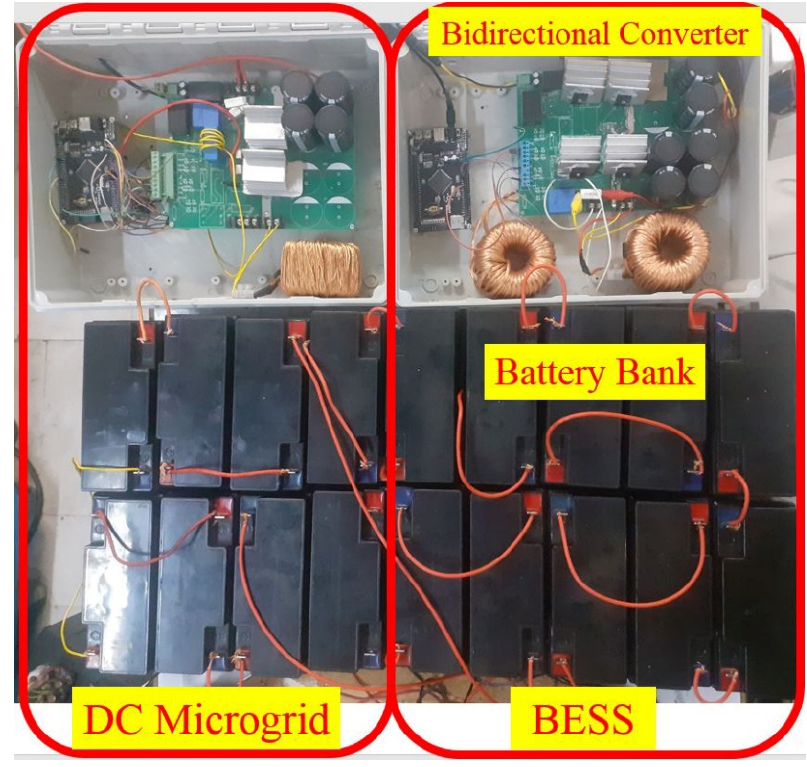
Figure 15. Experimental setup.